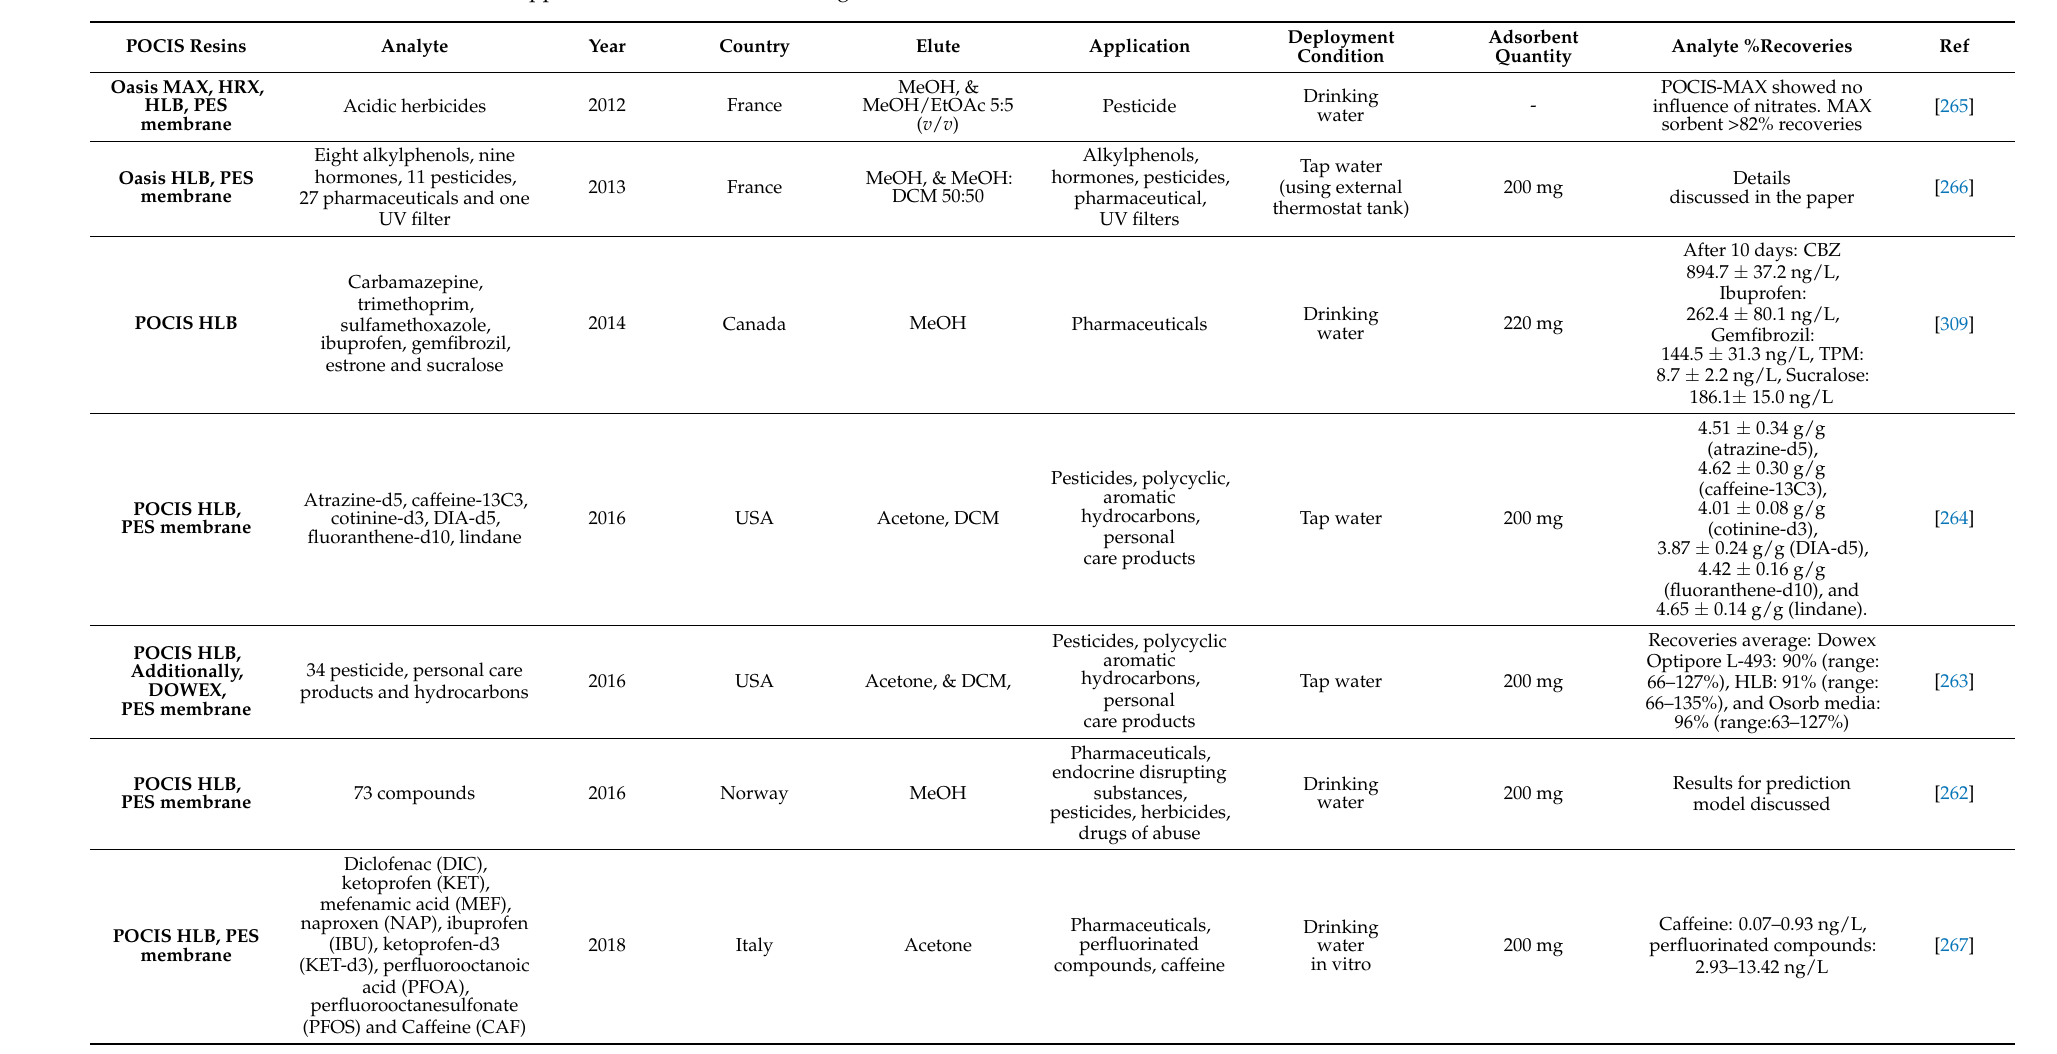
Table 10. Application of POCIS on drinking